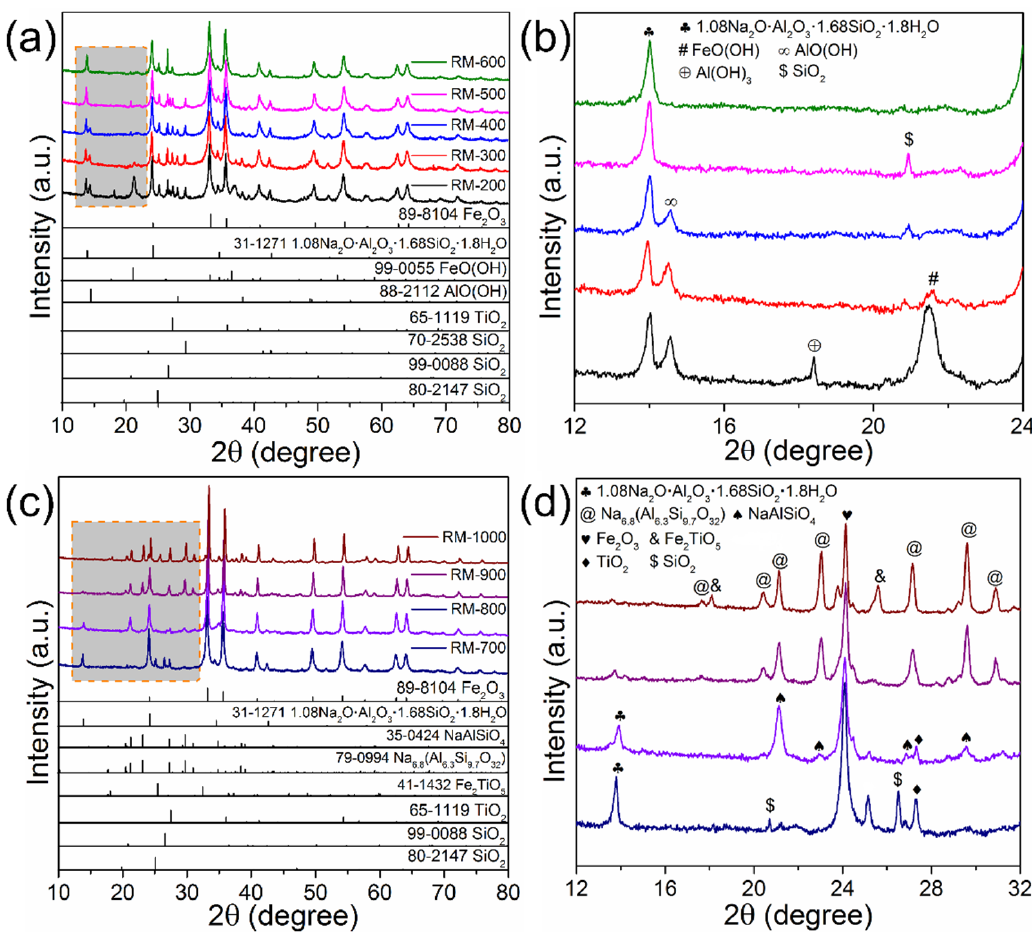
Figure 5. XRD patterns of red mud after calcination ( a, b ) RM-200, RM-300, RM-400, RM-500, RM-600, ( c, d ) RM-700, RM-800, RM-900, RM-1000.